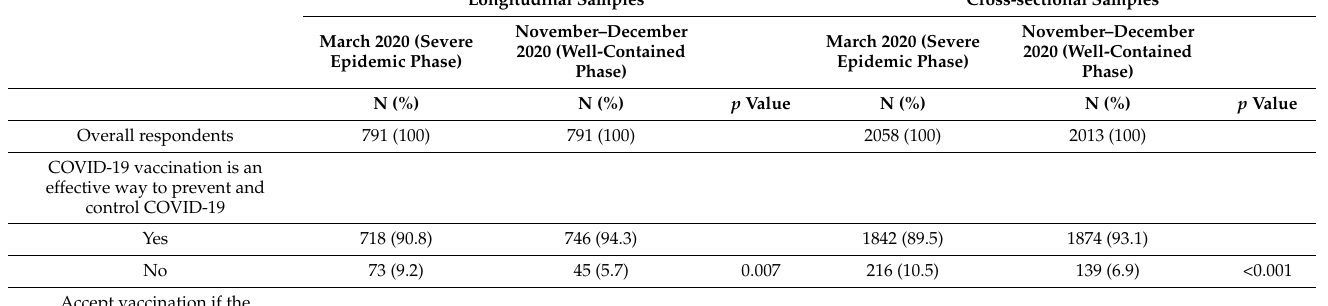
Table 1. The comparison of the acceptance of the COVID-19 vaccination between two consecutive surveys in severe epidemic phase (March 2020) and the well-contained phase (November–December 2020) [95]. Longitudinal Samples Cross-sectional